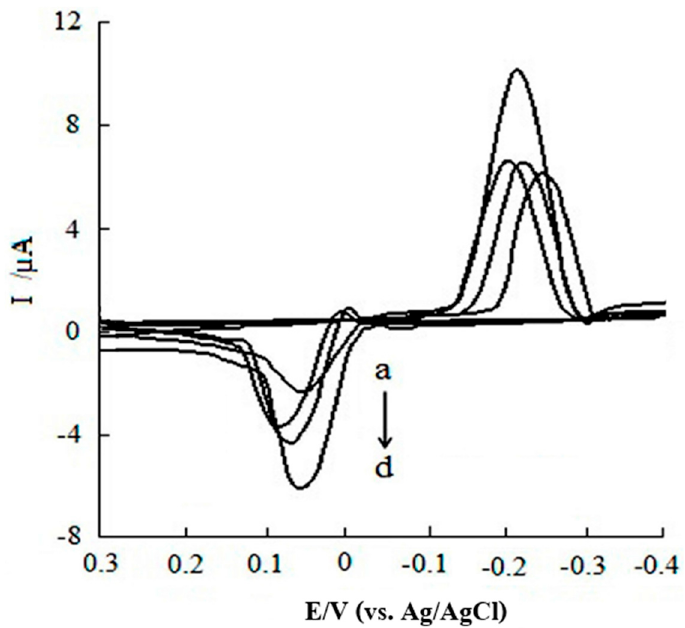
Figure 5. Influence of different supporting electrolytes on peak current: (a) 0.10 mol/L potassium hydrogen phosphate–potassium dihydrogen phosphate buffer; (b) 0.10 mol/L phosphate buffer solutions; (c) 0.10 mol/L citric acid buffer; (d) 0.10 mol/L acetic acid–sodium acetate buffer